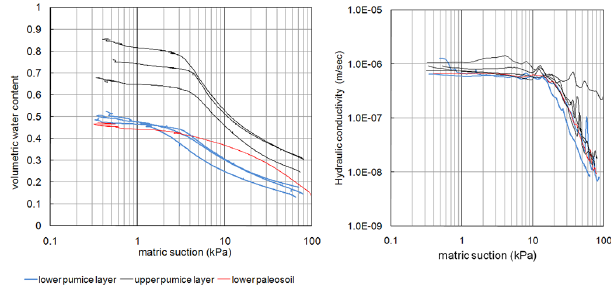
Figure 8. Soil water characteristic